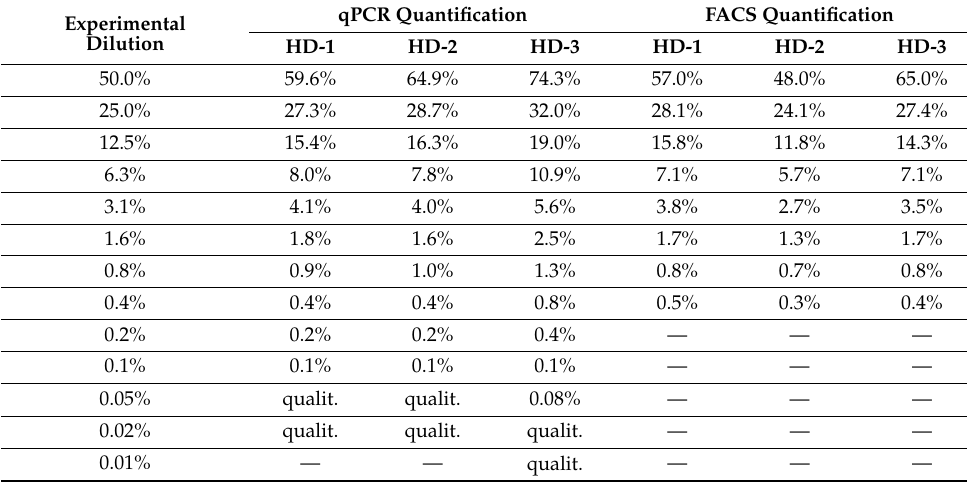
Experimental dilutions to 0.01% of HD-1 and HD-2 assessed by qPCR were measured with a Ct above the defined detection limit of Ct ≥ 35 (or no Ct) and excluded from quantification (—). Qualit. means a valid qualitative signal which was below the LLOQ but above the LLOD with a relatively high standard deviation (SD) in replicates. The lower detection limit for the flow-cytometry (FC) assay was approximately 0.4%. Dilutions to <0.4% were not detectable and excluded from flow-cytometry (FC) analysis (—).